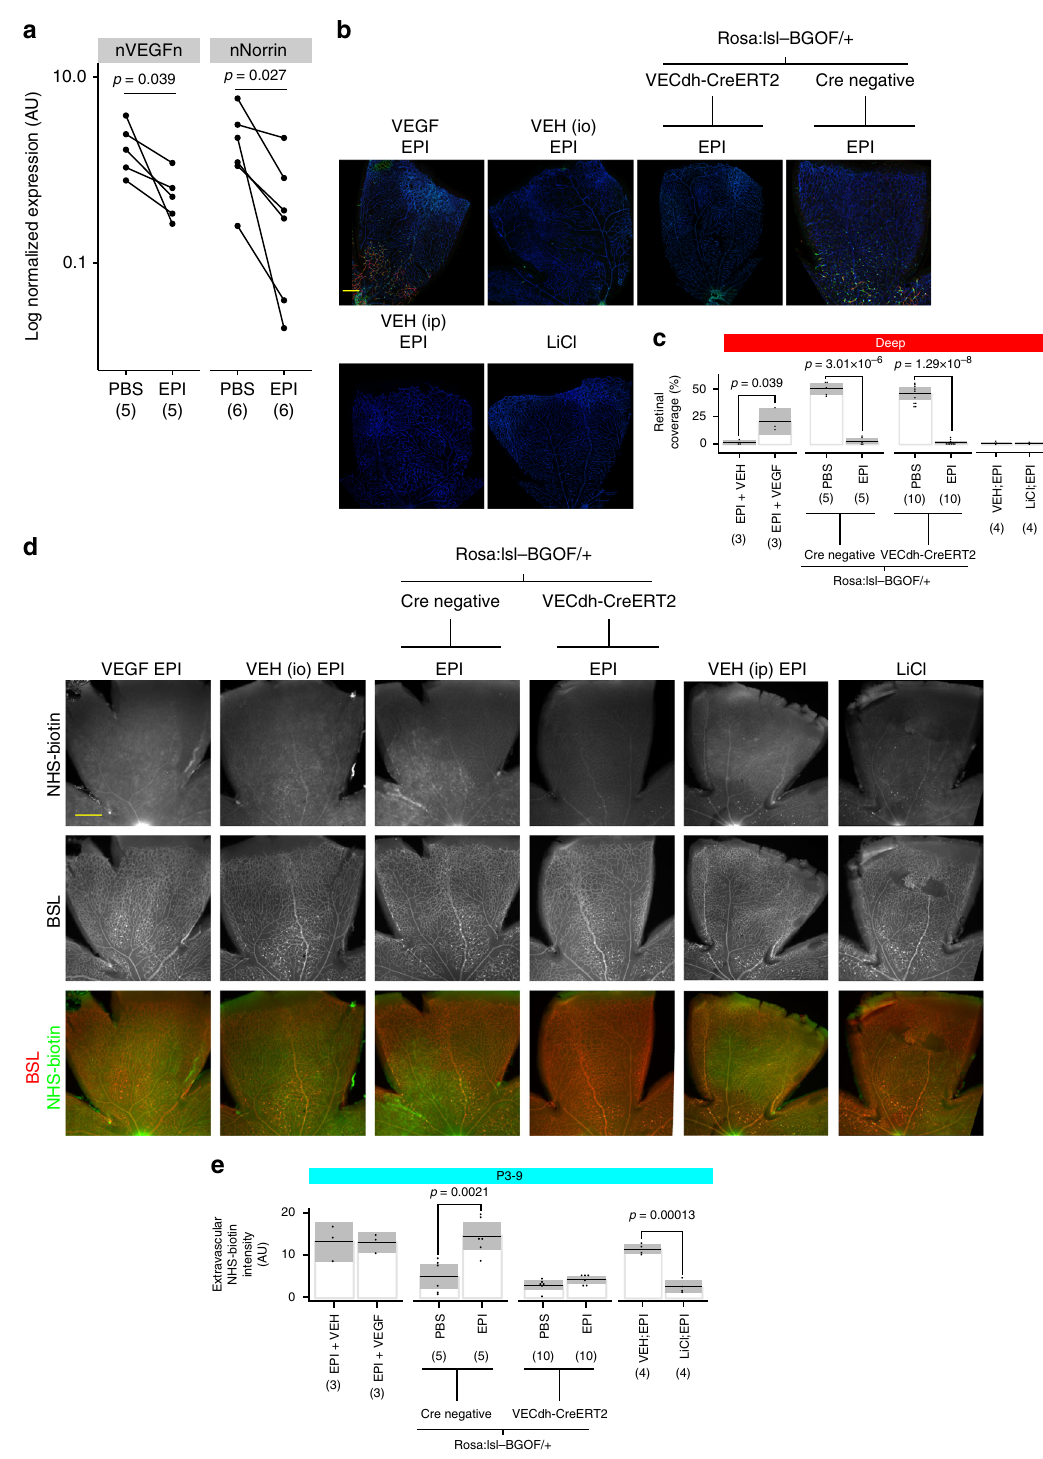
Fig. 3 VEGF limits angiogenesis and Norrin limits barrier function independently in the context of SAC activity blockade. a Expression of VEGF and Norrin was measured by Western blot after inhibition of SAC activity with EPI from P3 to P9. VEGF and Norrin expression are both decreased after activity blockade. b – e Recombinant VEGF was injected or beta-catenin activity was increased by expression of a stabilized form of beta-catenin (BGOF) in endothelial cells by removal of a lox-stop-lox sequence by Cre under the VE-Cadherin promoter (CreERT2) or systemic lithium chloride (LiCl) administration. The effects on deep vascular plexus growth ( b , c ) and NHS – biotin permeability ( d , e ) were examined. Scale bar is 200 µ m in each. d